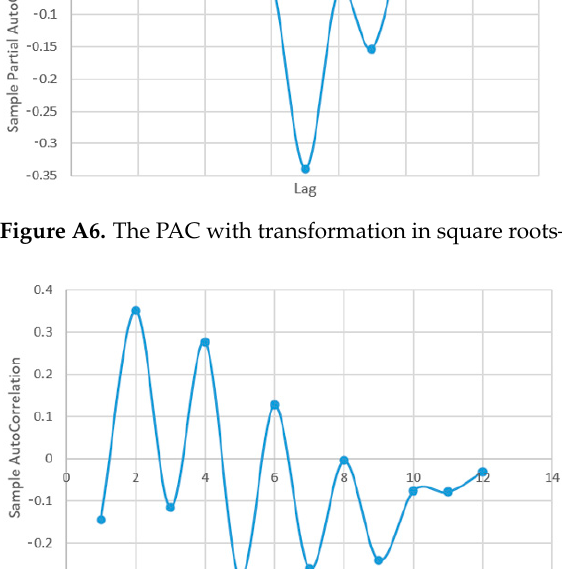
37 of 50 Figure A2. The PAC with transformation in square roots—Series A. Figure A3. The AC with transformation in square roots—Series B. Figure A4. The PAC with transformation in square roots—Series B.